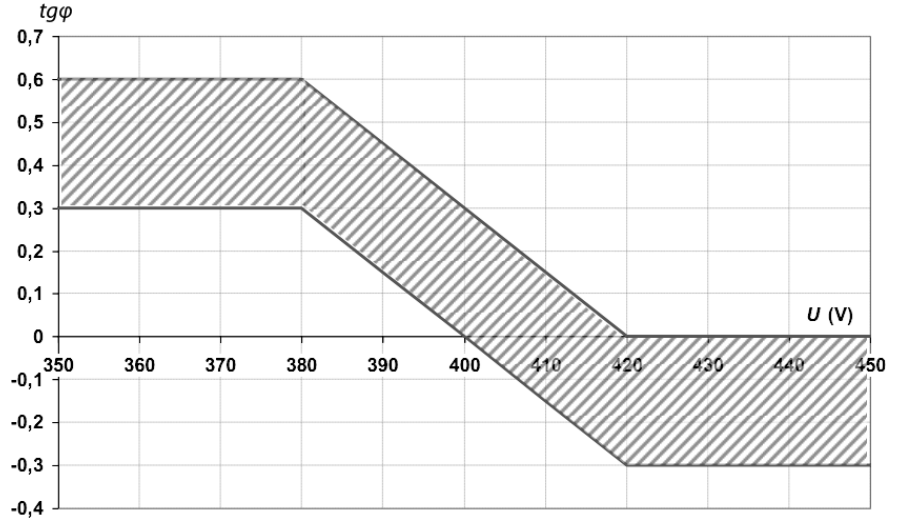
Figure 1. Example of static Q ( U ) characteristic for DG at full power, with up to 250 kW installed capacity, prescribed in Slovenia [4]. Similar characteristics are prescribed for the loads connected at LV or directly at MV